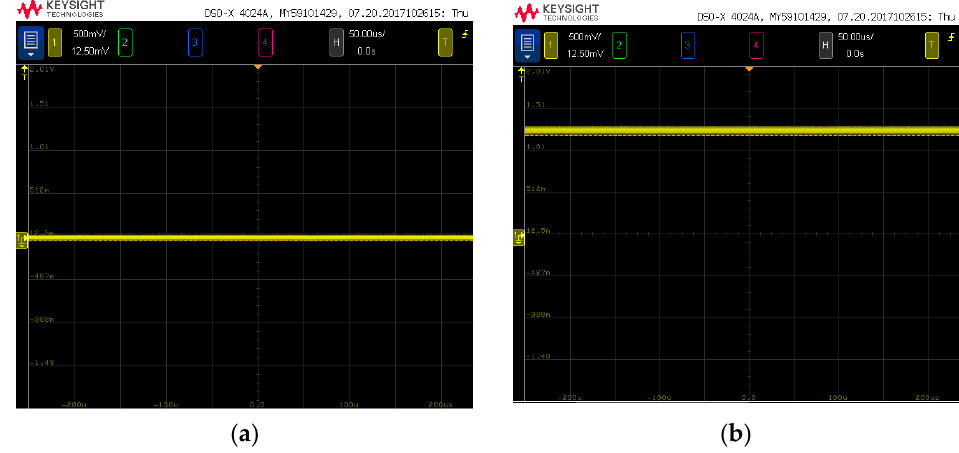
Figure 14. The output level of the lock detector. ( a ) The PLL is not locked; ( b ) the PLL is locked.